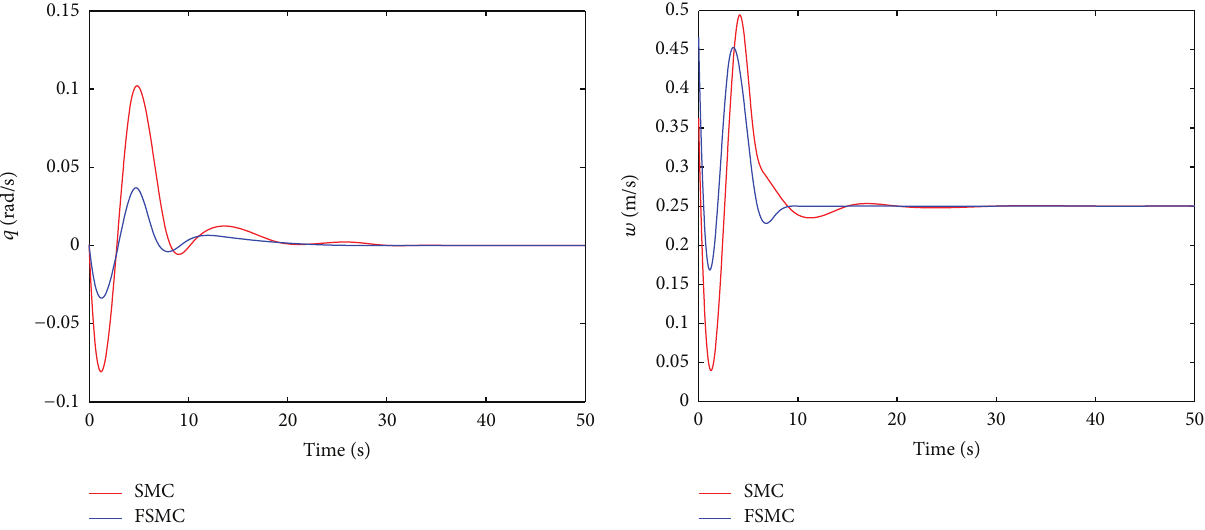
Figure 6: Changing curves of pitch rate and heave velocity.